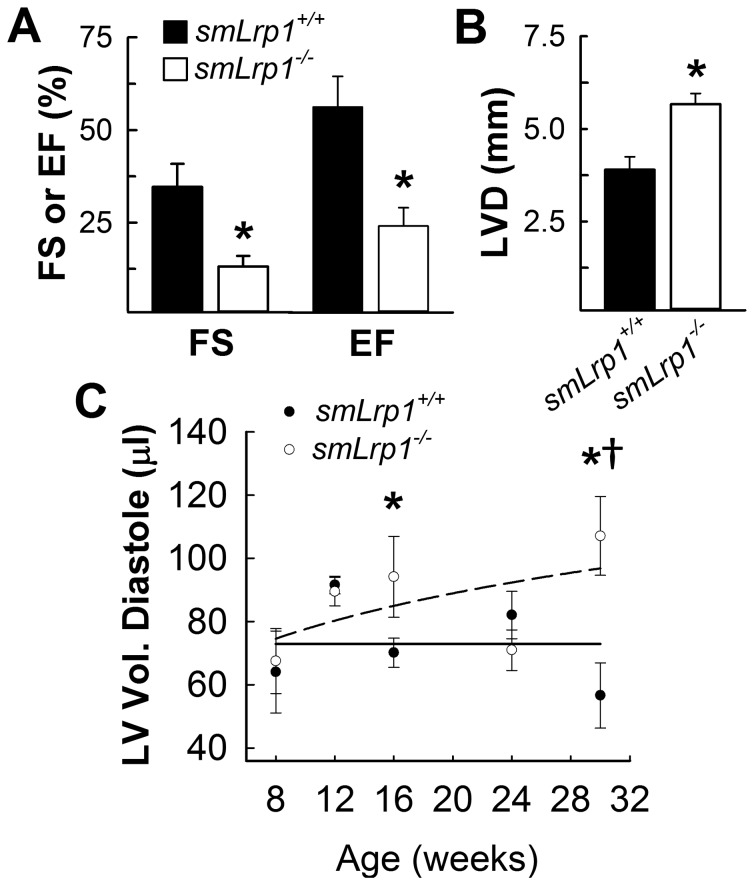
Cardiac output and left ventricular dilation.
A, Fractional Shortening (FS), Ejection Fraction (EF) and (B) Left ventricular diameter in diastole (LVVD) measurements collected from 36 week old smLrp1
+/+ and smLrp1
-/- mice. * P<0.05 C, Left ventricular volumes during diastole were determined during the 22 week study period with echocardiograms at indicated intervals. *P<0.01, versus aortic root diameter of eight week old smLrp1
-/- mice; †P<0.05, pair wise comparison among age-matched smLrp1
+/+ mice.